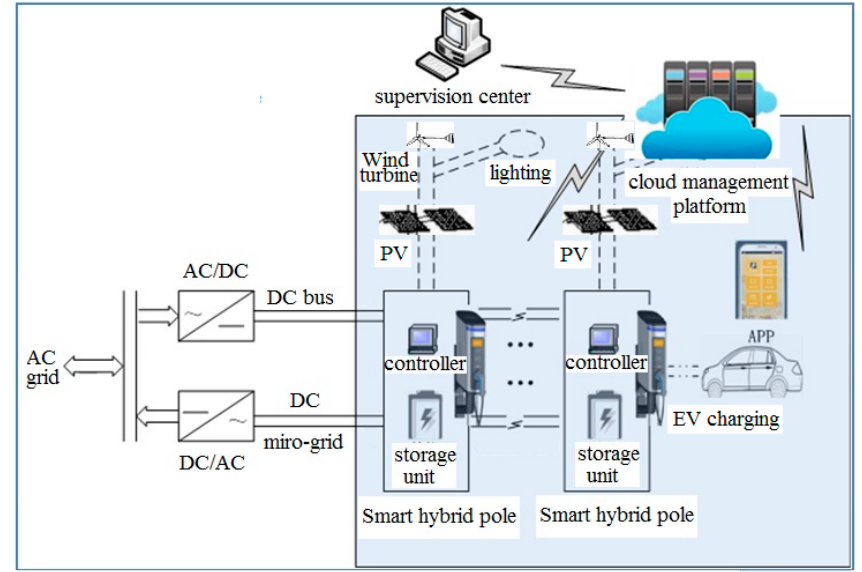
Figure 7. The cloud management system of smart hybrid poles group.